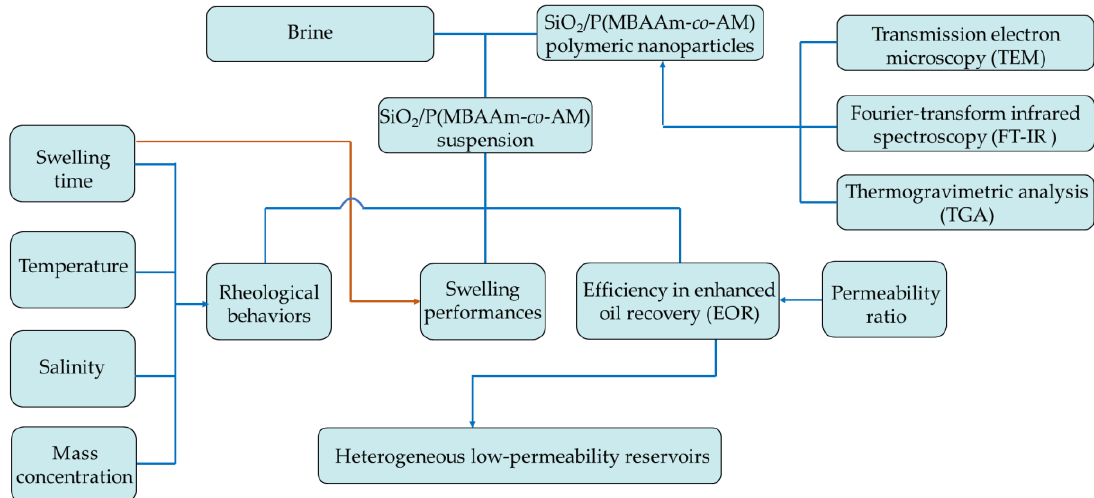
Figure 1. General sketch of this present research.